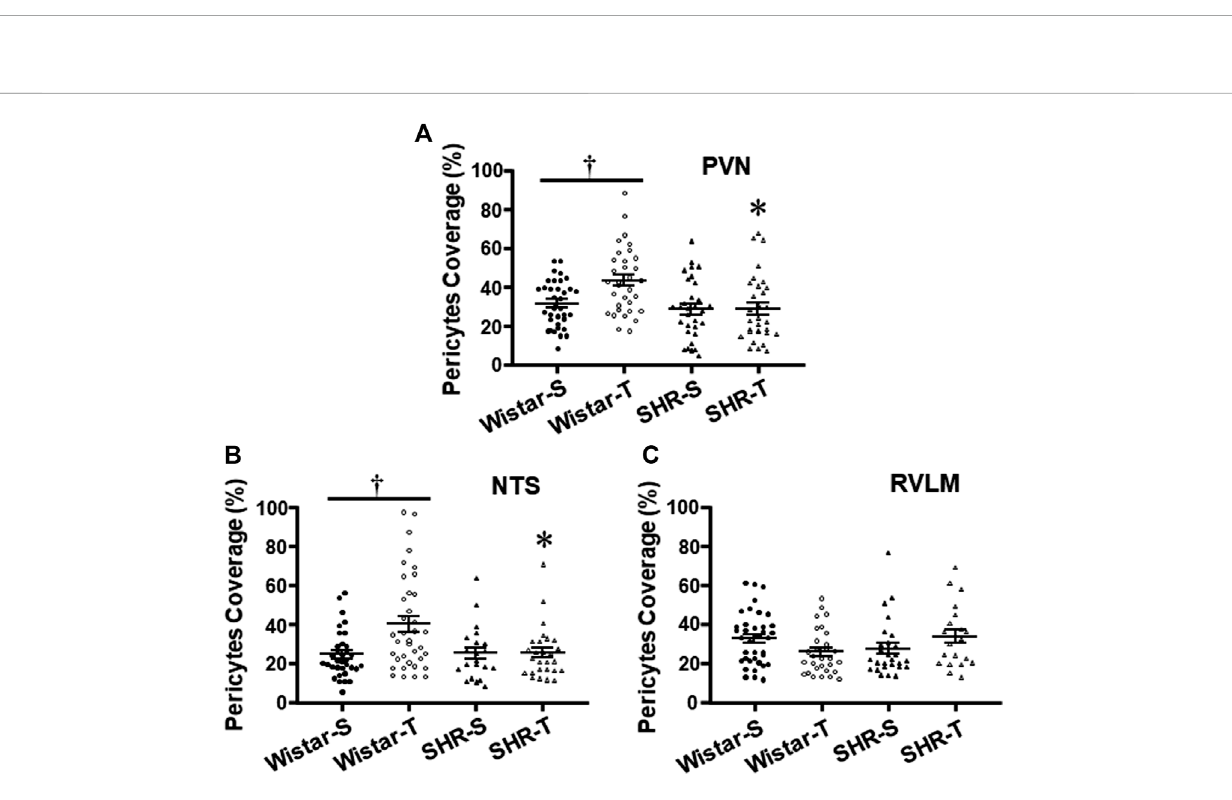
FIGURE 5 Effects of hypertension and exercise training on pericytes coverage of endothelial cells within the PVN (A) , NTS (B) ,and RVLM (C) capillaries. n = 5 – 11 capillaries/area/rat, 3 rats/group. Comparisons made by two-way factorial ANOVA. Signi fi cances ( p < 0.05) are * vs. respective Wistar group; † vs. respective S